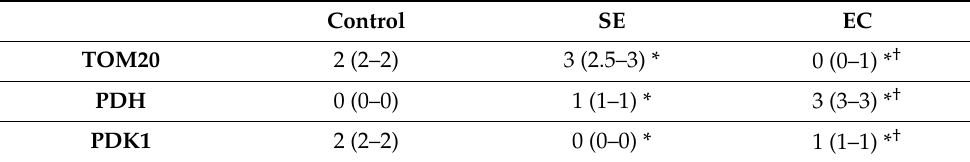
Figure 5. Oxidative mitochondrial expression in control testis and TGCTs. Scale bars: 25 μ m . Table 4. Oxidative mitochondrial protein expression in control and TGCTs.